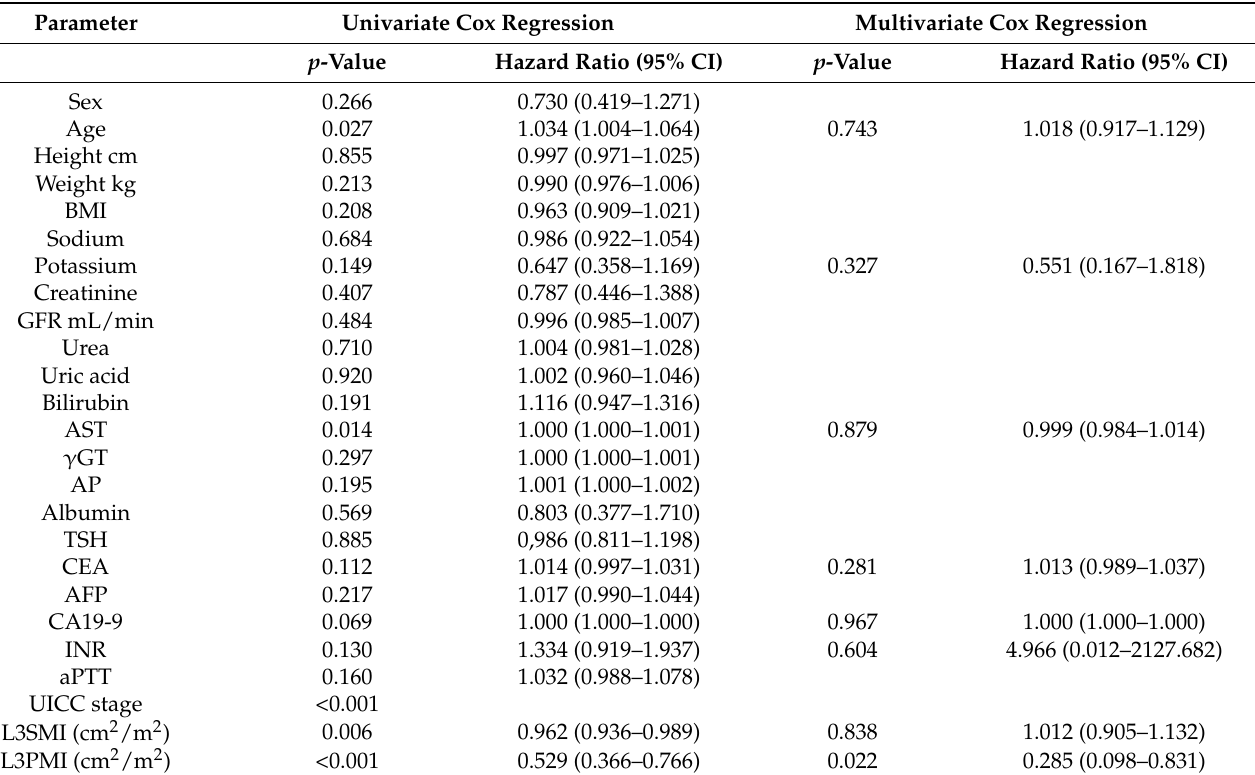
BMI: Body-Mass Index, GFR: glomerular filtration rate, AST: aspartate-aminotransferase, γ GT: γ -glutamyltransferase; AP: Alkaline phosphatase; TSH: Thyroid-stimulating hormone, CEA: Carcinoembryonic antigen, AFP: α -fetoprotein, CA19-9: Carbohydrate antigen 19-9, INR: International normalized ratio, aPTT: activated partial thromboplastin time; for multivariate Cox regression analysis variables with a p -value < 0.150 in univariate Cox regression analysis were